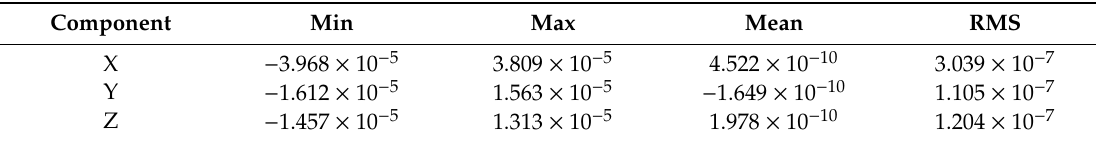
Table 1. Accuracy analysis of equally sampled and unequally sampled di ff erential accelerations in IRF (unit: m / s 2